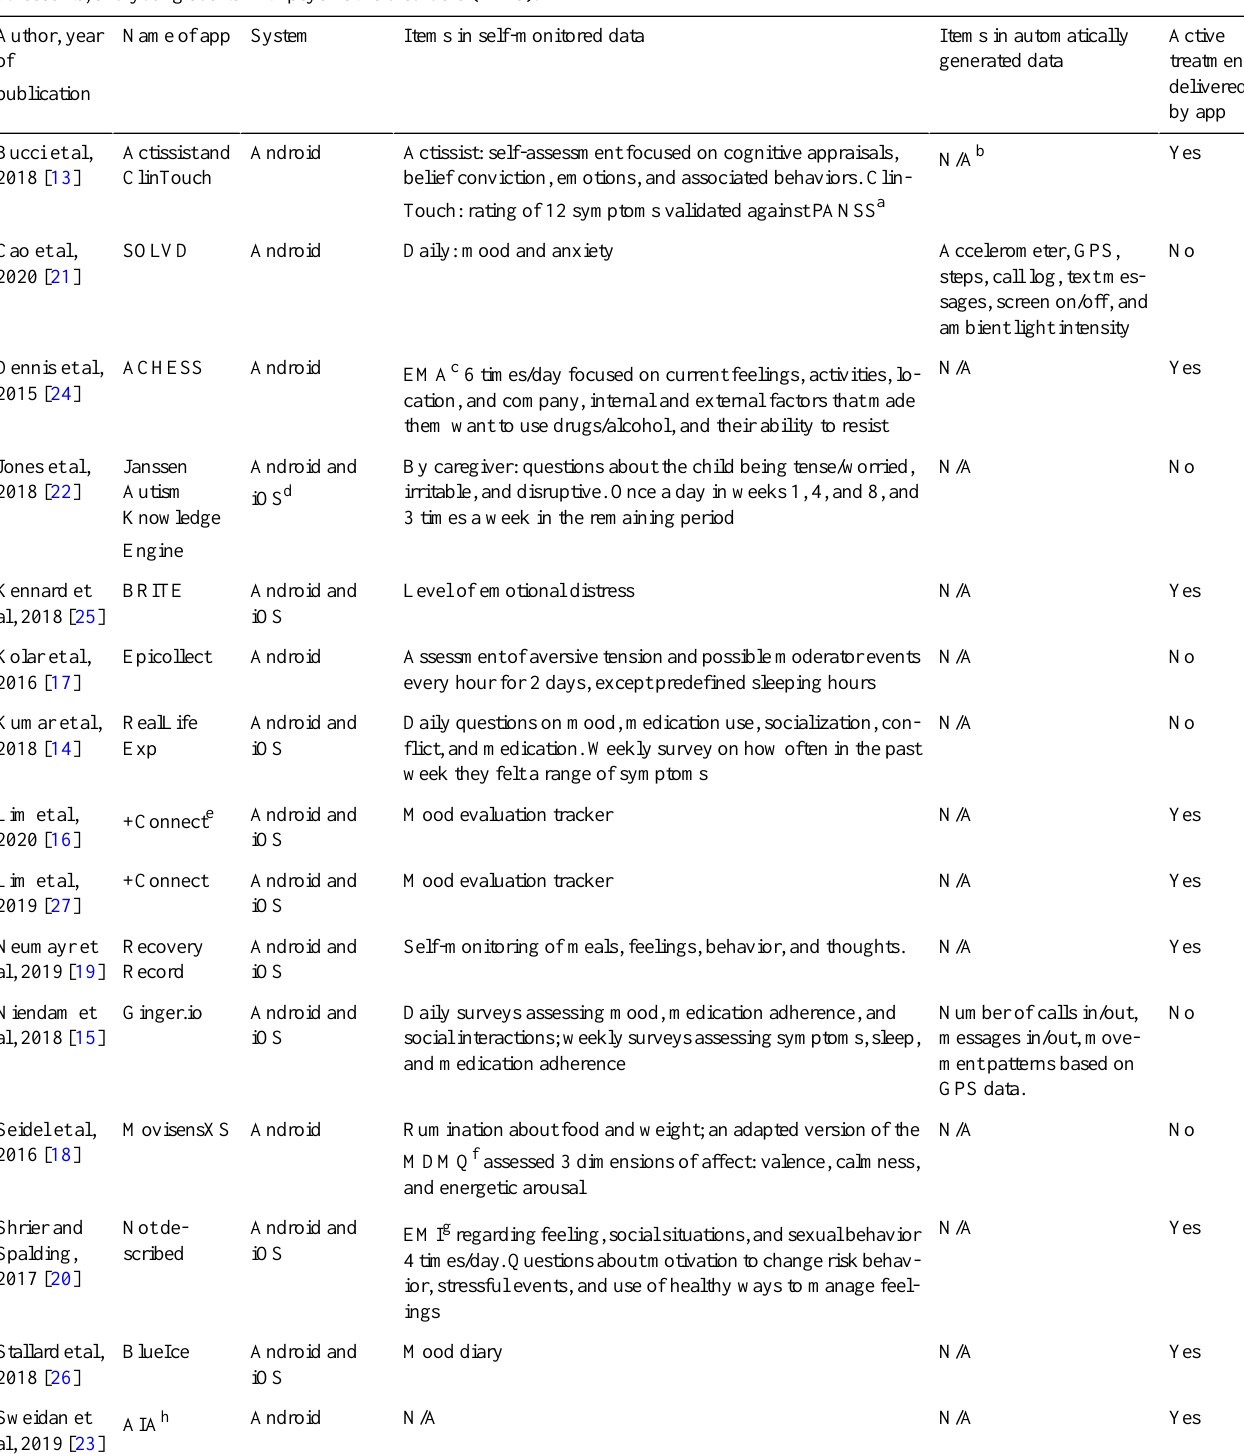
Table 2. Description of the app used in studies on self-monitoring, treatment, and automatically generated data collected via smartphones in children, adolescents, and young adults with psychiatric disorders (N=15).